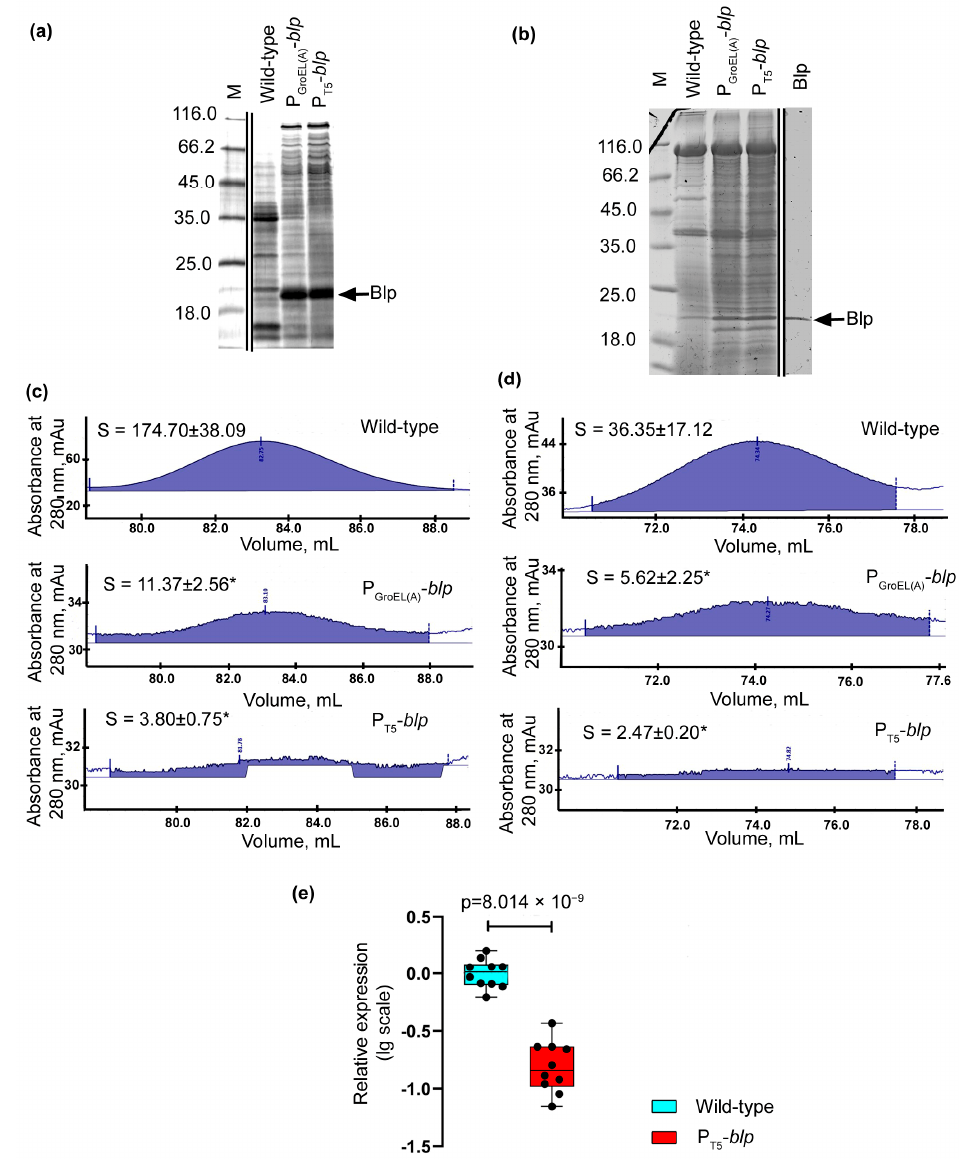
Figure 4. Comparative analysis of the production of some proteins in cells of L. capsici strains. ( a ) SDS-PAGE: Lanes correspond to samples of the culture liquid of L. capsici strains (Supplementary Figure S6). The gel was stained with imidasole–ZnCl 2 solution. ( b ) SDS-PAGE: Lanes correspond to samples of L. capsici strain cells and purified Blp of L. capsici VKM B-2533 T (Supplementary Figures S7 and S8). The gel was stained with a solution of Coomassie Brilliant Blue R-250. ( c ) Peak area of protein L1 at purification on a Hiload 16/60 column (Superdex 75). The mean values were obtained in two independent experiments, each with two technical replicates. The two groups were compared using a two-sided Mann–Whitney U -test ( p = 0.0286). ( d ) Peak area of a mixture of serine proteases at the purification on a Hiload 16/60 column (Superdex 75). The mean values were obtained in two independent experiments, each with two technical replicates. The two groups were compared using a two-sided Mann–Whitney U -test ( p = 0.0286). ( e ) Relative level of expression of the alpA gene in L. capsici P T5 - blp . The boxplots show the median and IQR. The values were obtained in four independent experiments, each with two technical replicates. The two groups were compared using an unpaired two-tailed Student’s t -test, t = 10.07, df = 18, * p =